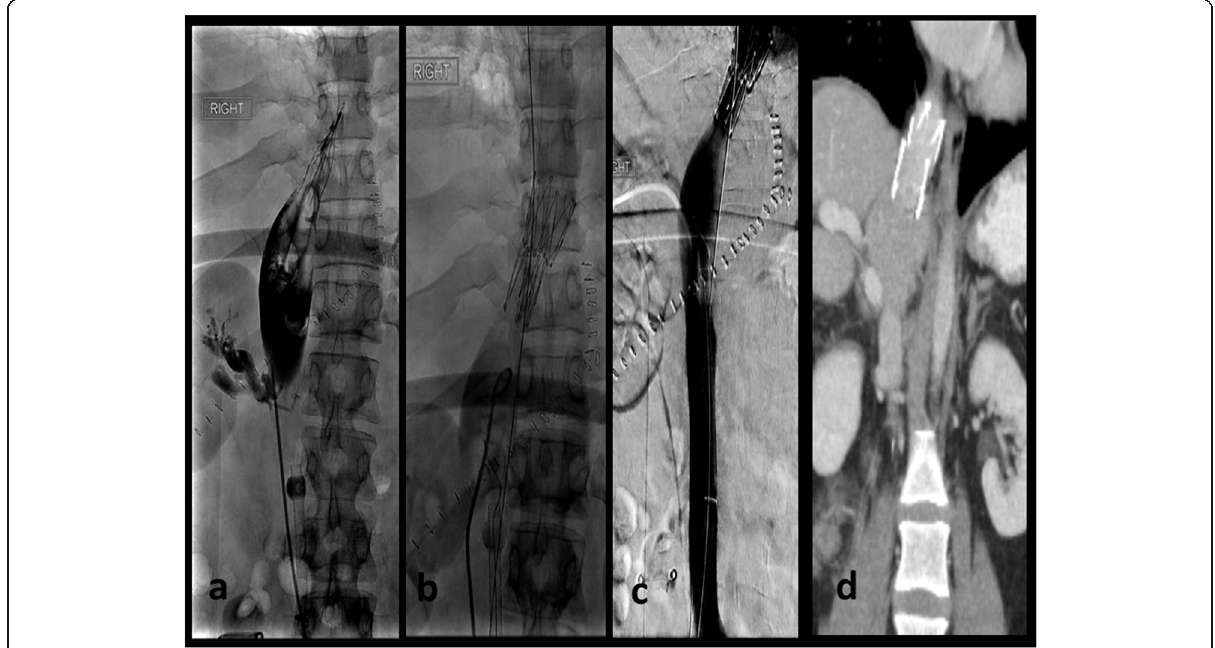
Fig. 4 After filter placement, the patient was hypotensive with oliguria and elevated liver enzymes. CT showed extensive thrombus in the IVC. a . and b . Venogram demonstrated large clot burden in the IVC distal to the filter with AngioVac thrombectomy device in place. Z stent was placed at the site of the kinked area. c . and d . Venogram following Z stent placement showed a widely patent IVC. Coronal contrast enhanced CT image of the abdomen demonstrates a patent stent in the intrahepatic IVC